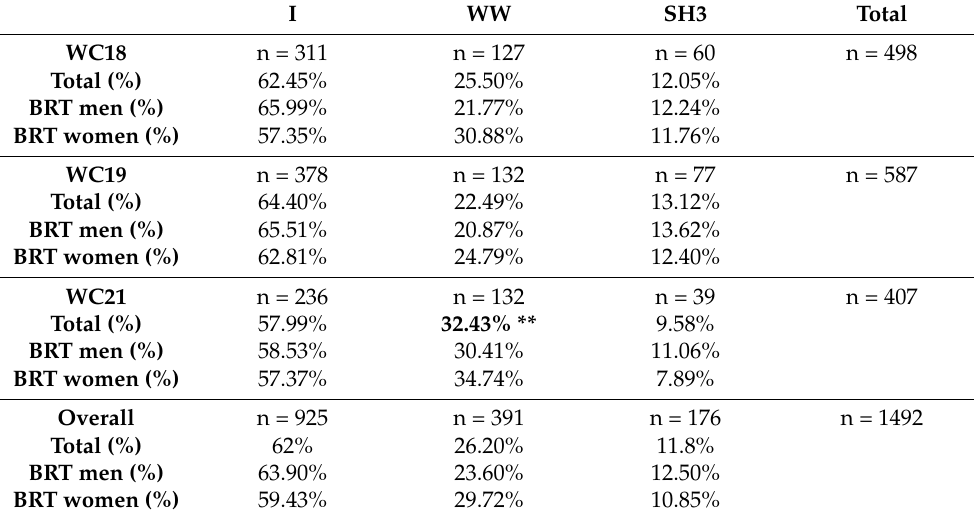
** SRs with a value equal or higher to 2. SRs = standardised